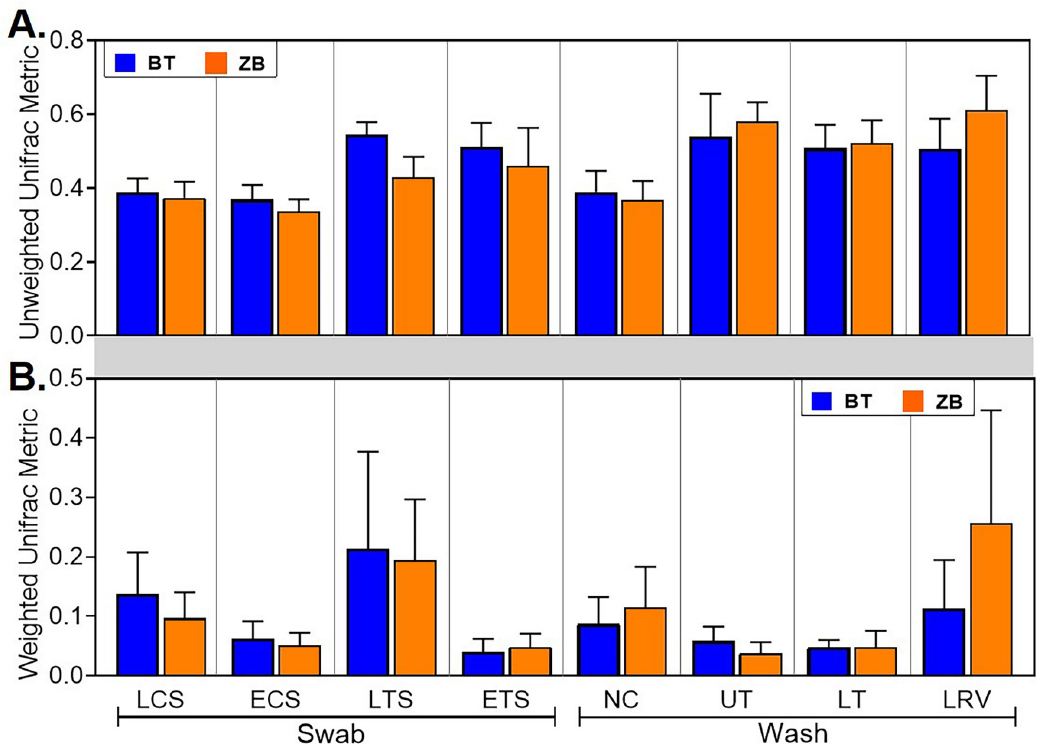
Fig 7. Comparison of beta diversity metrics from samples extracted using the BT and ZB kits. Unweighted (A) and Weighted (B) UniFrac distances were compared between samples from a given sample type. No statistical differences were found between the kits (pairwise permutational multivariate analysis of variance, PERMANOVA, with a Benjamini-Hochberg correction for false discovery). LCS, live choanal swab; ECS, euthanized choanal swab; LTS, live tracheal swab; ETS, euthanized tracheal swab; NC, nasal cavity wash; UT, upper trachea wash; LT, lower trachea wash; LRV, lower respiratory